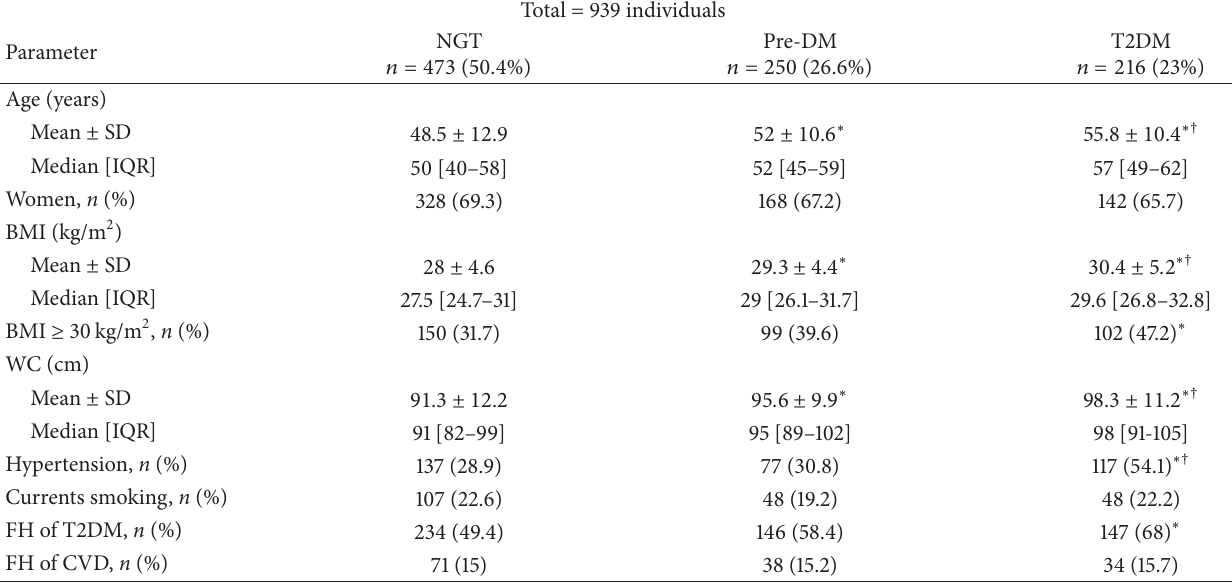
Table 1: Demographic and clinical characteristics of the overall sample categorized according to glucose tolerance